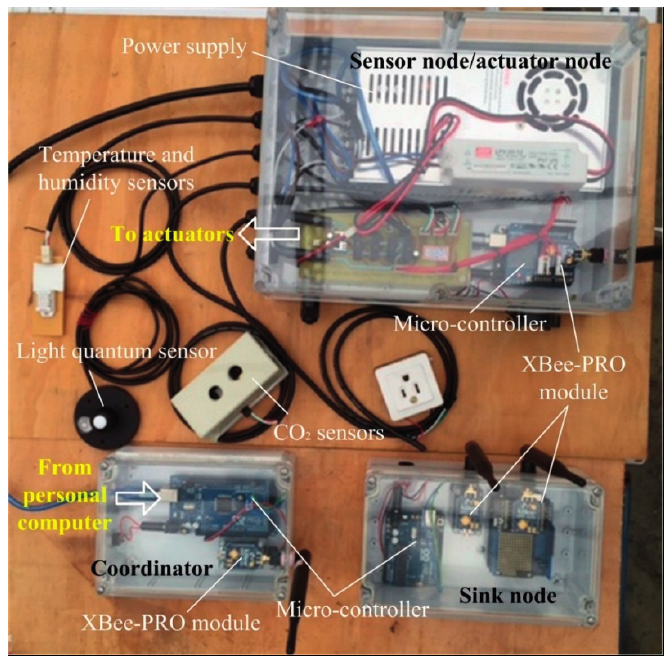
Figure 5. The MEM-based components in the